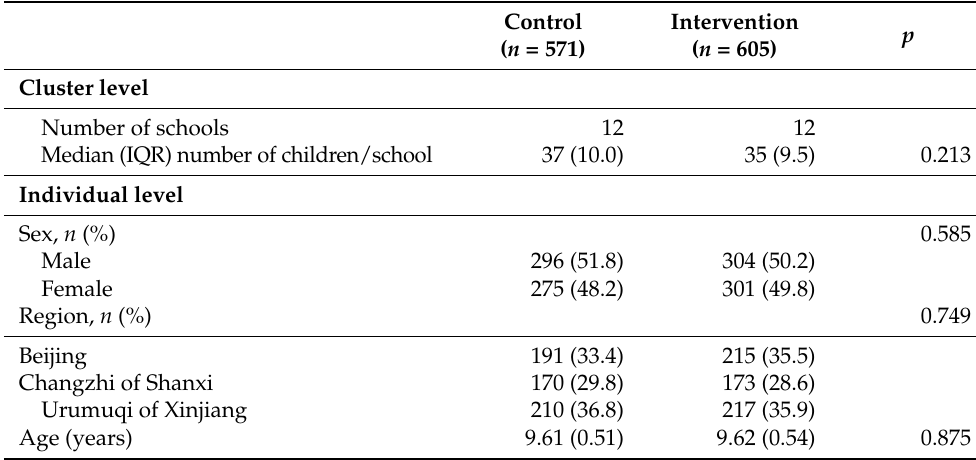
Figure 1. Flow Diagram of Selecting Study Participants. Table 1. The characteristics of the two groups at baseline a